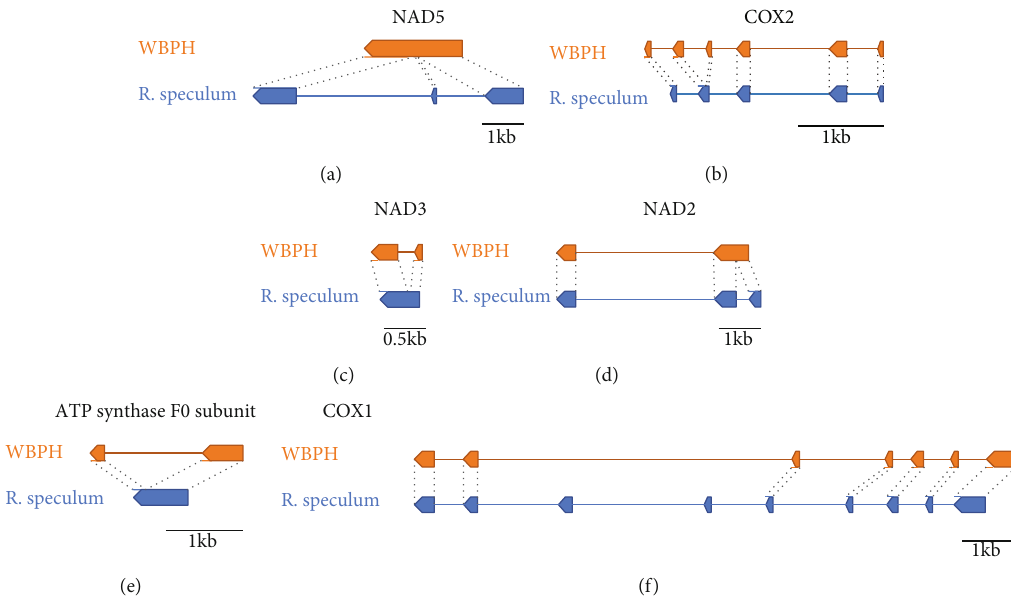
Figure 2: Schematic diagram of exon/intron structure of protein-coding genes displaying di ff erent con fi gurations between fungal endosymbiont mitogenomes of WBPH and R. speculum . Orange-colored diagrams indicate components of WBPH fungal endosymbionts, and blue-colored diagrams are those of R. speculum fungal endosymbionts. Exon/intron structures of (a) NAD5 , (b) COX2 , (c) NAD3 , (d) NAD2 , (e) ATP synthase F0 subunit, and (f) COX1 are displayed. Table 3: List of intraspeci fi c variations identi fi ed on the fi ve WBPH fungal endosymbiont mitogenomes.